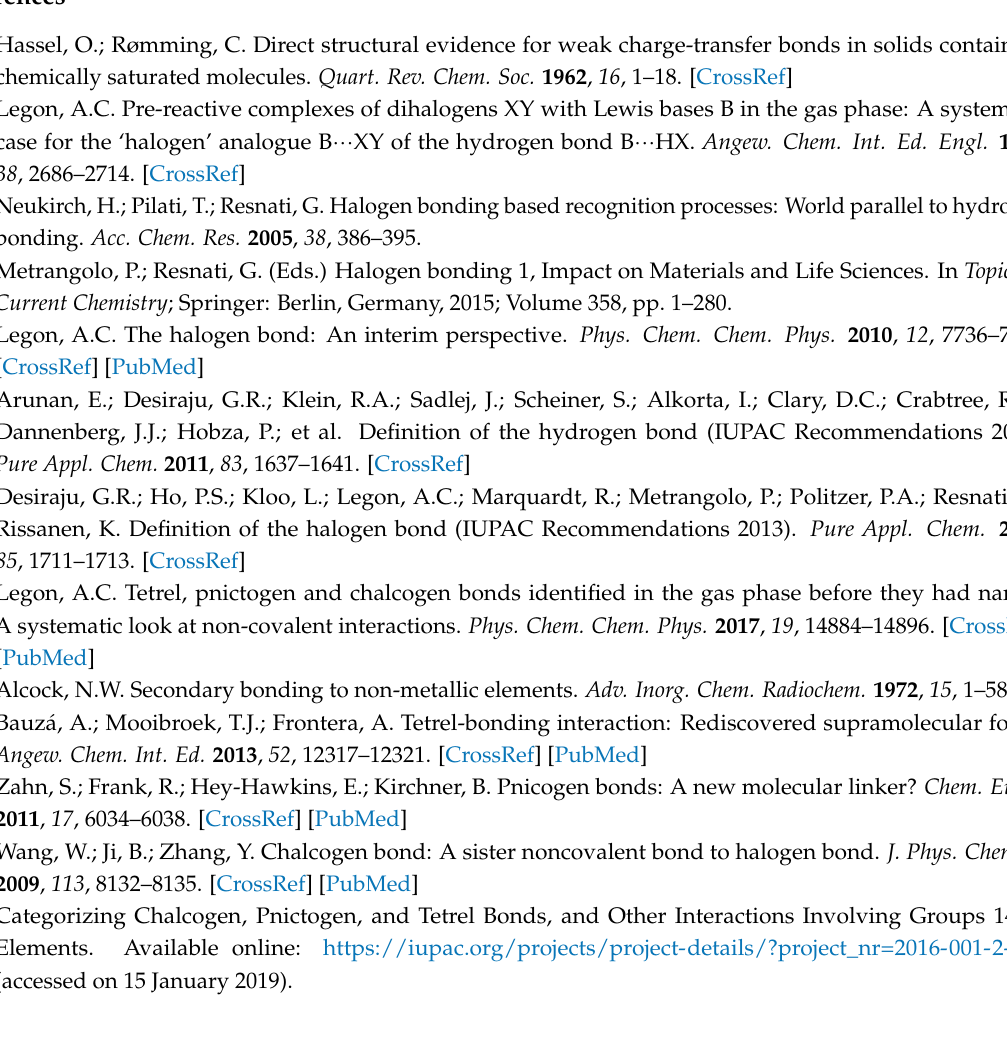
Figure S1: Molecular electrostatic surface potentials of the linear, non-polar molecules, MgF 2, MgH 2 and Mg(CH 3 ) 2 calculated at the 0.001 e/bohr 3 electron density isosurface at the CCSD/aug-cc-pVTZ//CCSD(T)/aug-cc-pVTZ level of theory, Table S1: Optimized geometry, electronic energy and Variation of the energy E(r − r e ) as a function of the displacement ( r − r e ) from the global minimum at r e at the CCSD(T)/aug-cc-pVTZ computational